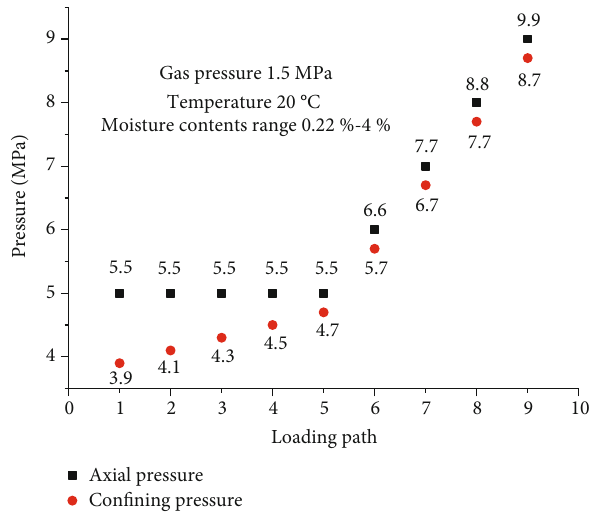
Figure 5: The loading path of the prepared samples with di ff erent moisture